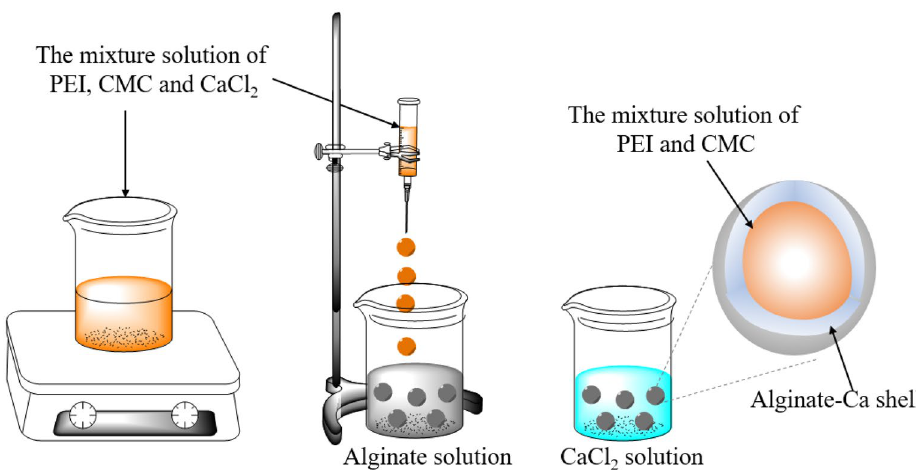
Figure 1. Schematic diagram for the preparation of PEI-Alginate